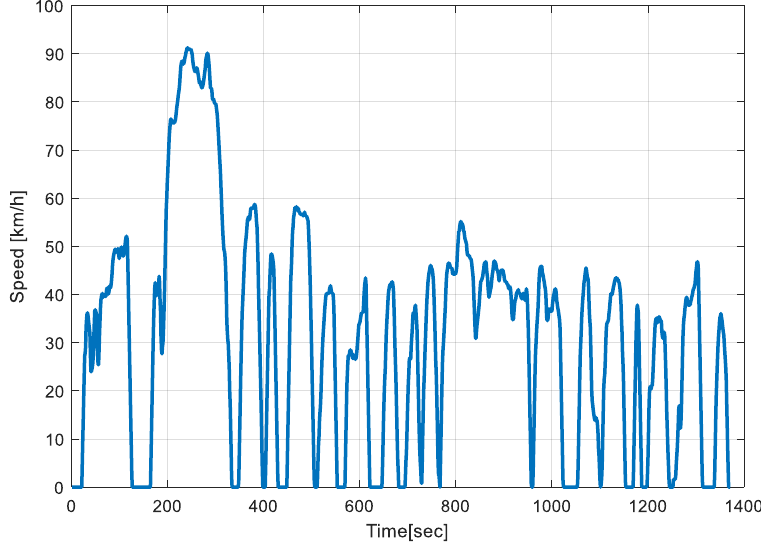
Figure 13. Urban Dynamometer Driving Schedule (UDDS) condition.